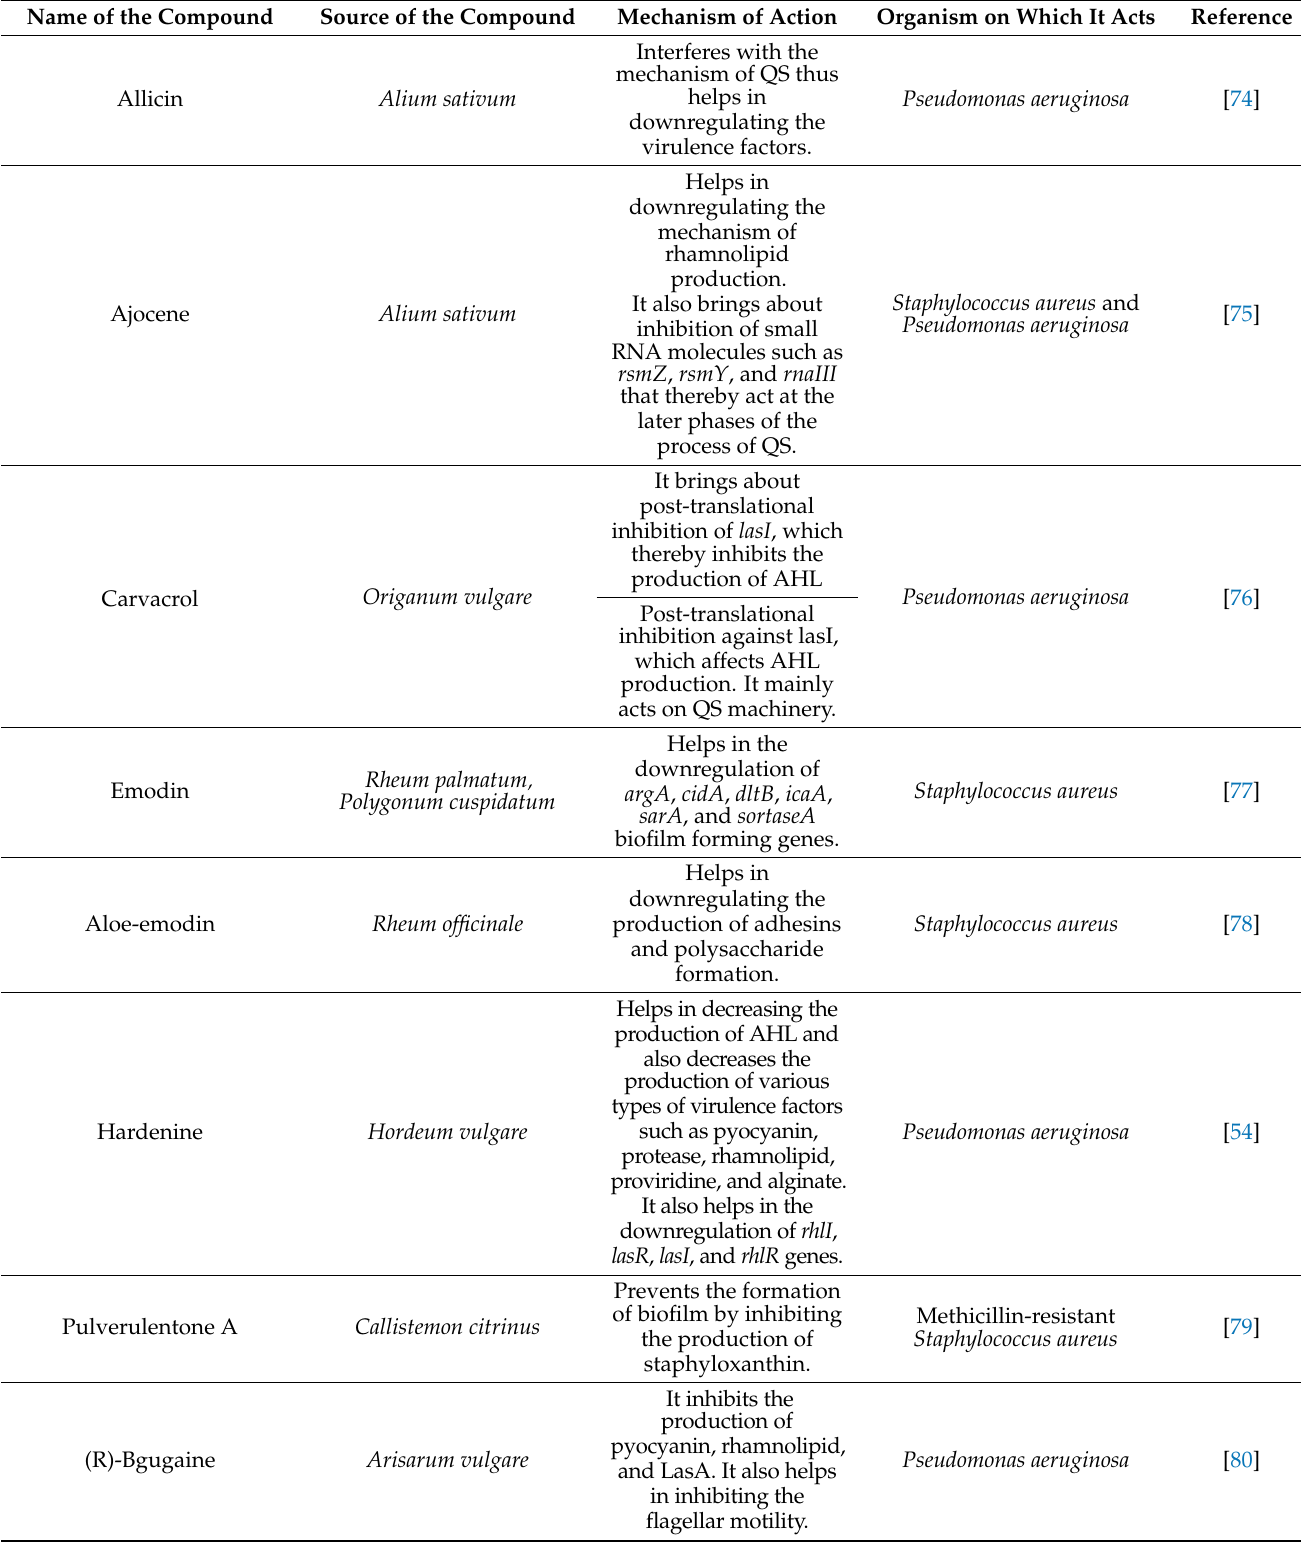
Table 1. Phytochemicals and their mechanism of clearing ESKAPE pathogenic